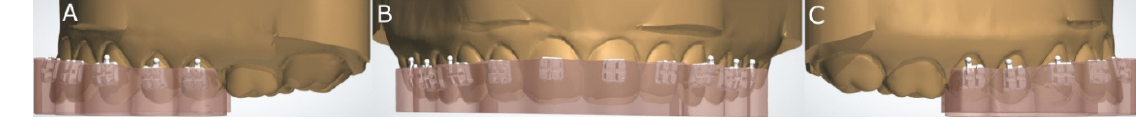
Figure 2. ( A ) Lateral left, ( B ) frontal, and ( C ) lateral right view of the orthodontic template digitally planned on the experimental anatomically based models.